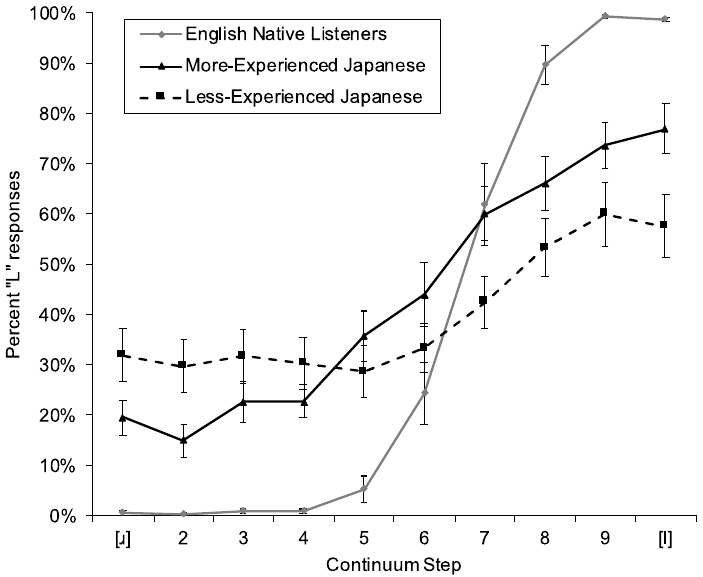
Figure 2. Mean percent “L” responses from the R-L identification task for the three participant groups. Error bars represent standard errors of the mean.